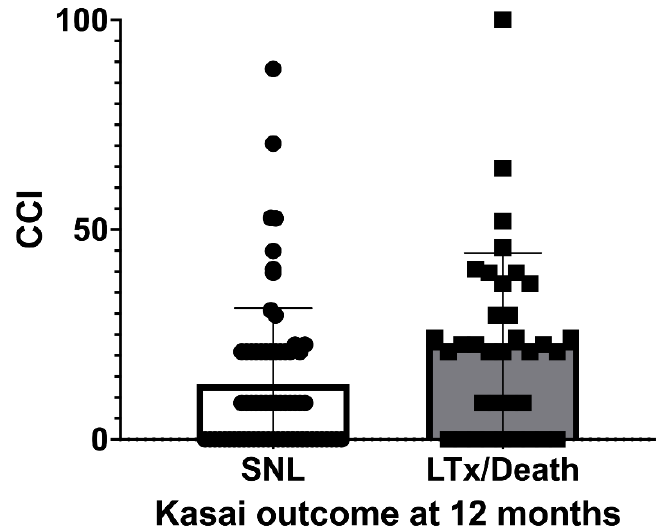
Figure 1. Boxplot showing median CCI ® (standard deviations, maximum scores) after Kasai proce- dure in group of children with native liver survival (SNL) and group with liver transplantation or death (LTx/Death) at 12-month follow-up. death (LTx/Death) at 12-month